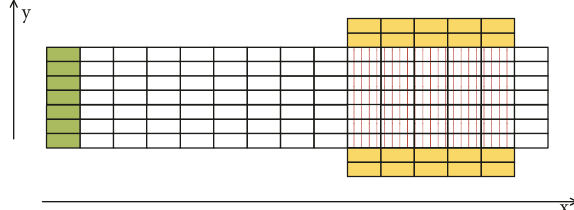
Figure 4: Illustration of modeling scene for conventional bus stop.